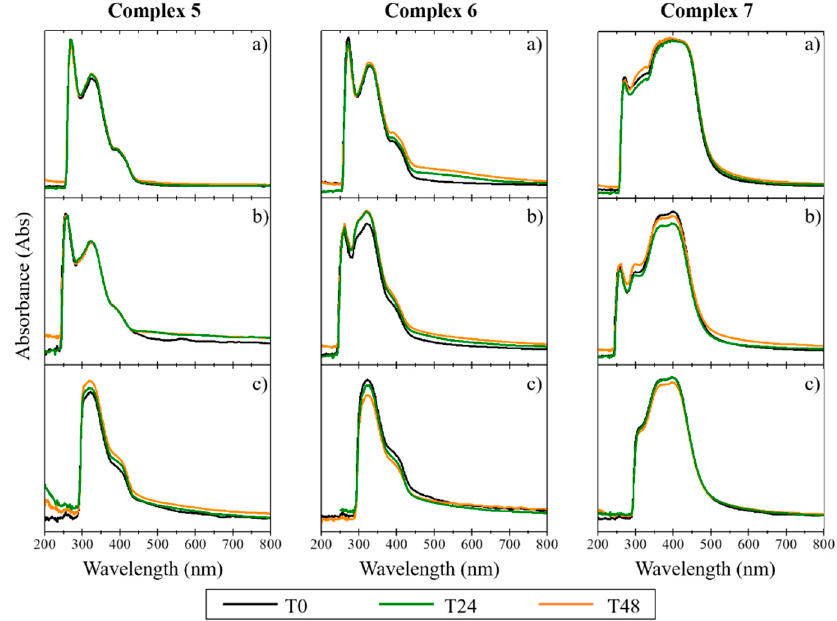
Figure 3. UV/Vis spectra of silver complexes ( 5 , 6 , and 7 ) in DMSO solution ( a ), and in phenol red-free DMEM in the absence ( b ) and presence of FBS ( c ). The data were collected at T = 0 h (T0), T = 24 h (T24), and T = 48 h (T48) after creating the complex solutions.